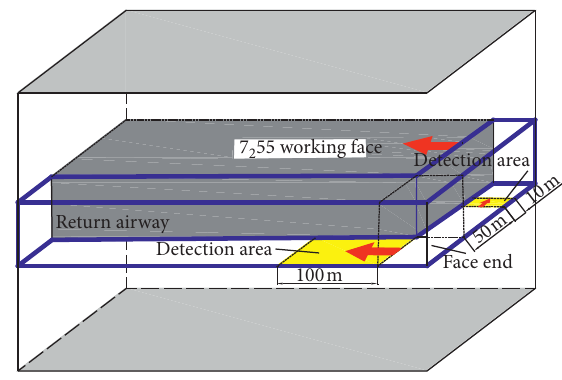
Figure 3: Schematic diagram of the detection